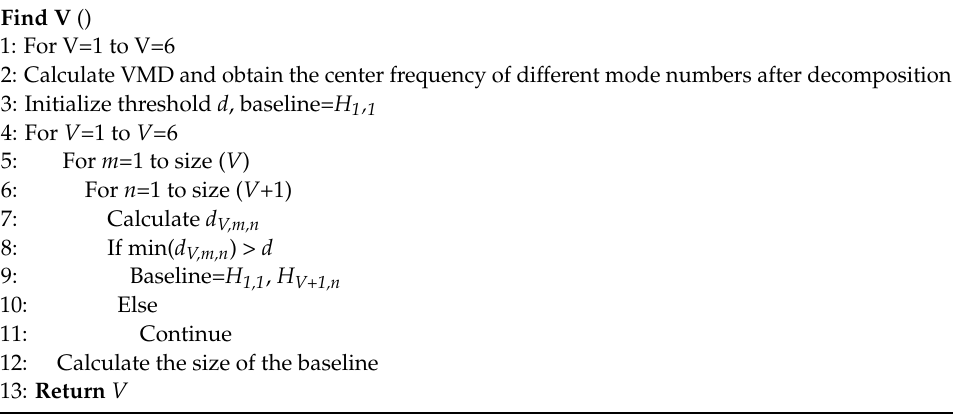
Algorithm 1. Automatic choice of a suitable mode number